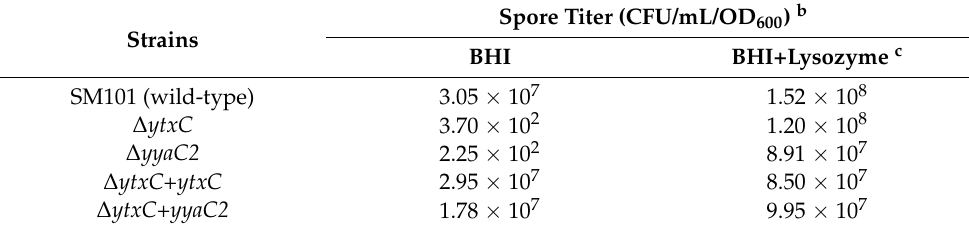
Spore Titer (CFU/mL/OD 600 )